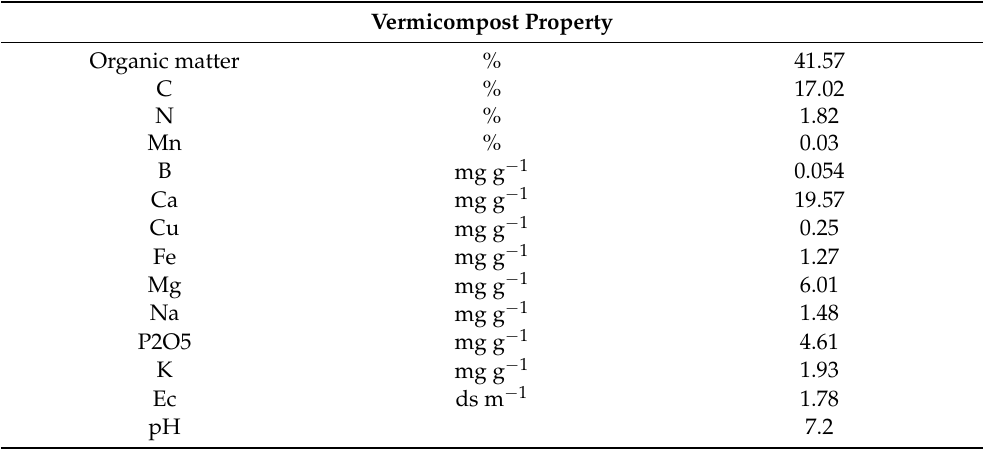
Table 11. The physical and chemical properties of the used vermicompost.